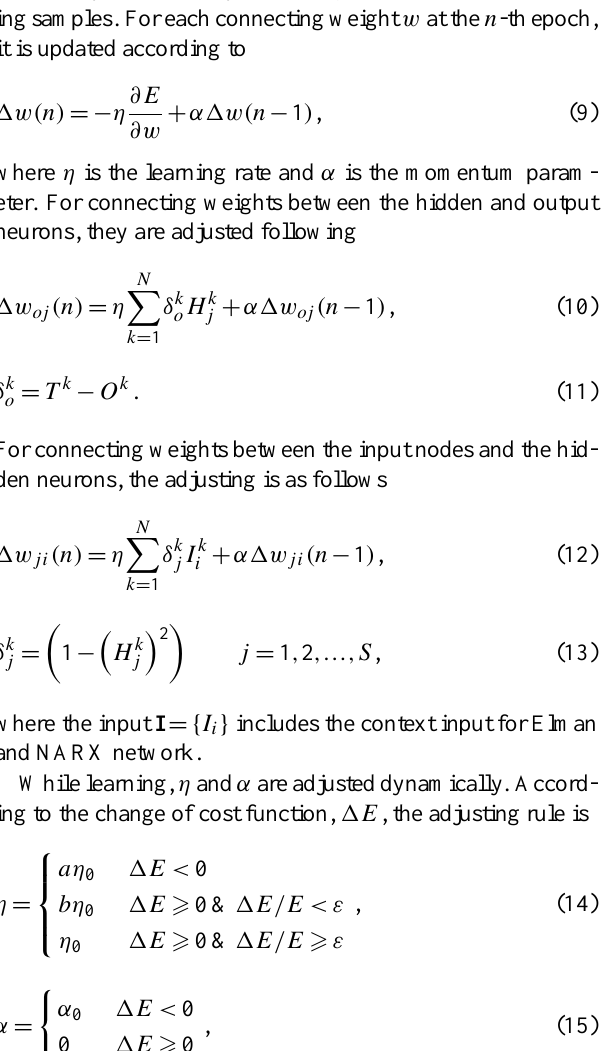
Fig. 1. Histogram of minimum SYM-H index for the events used